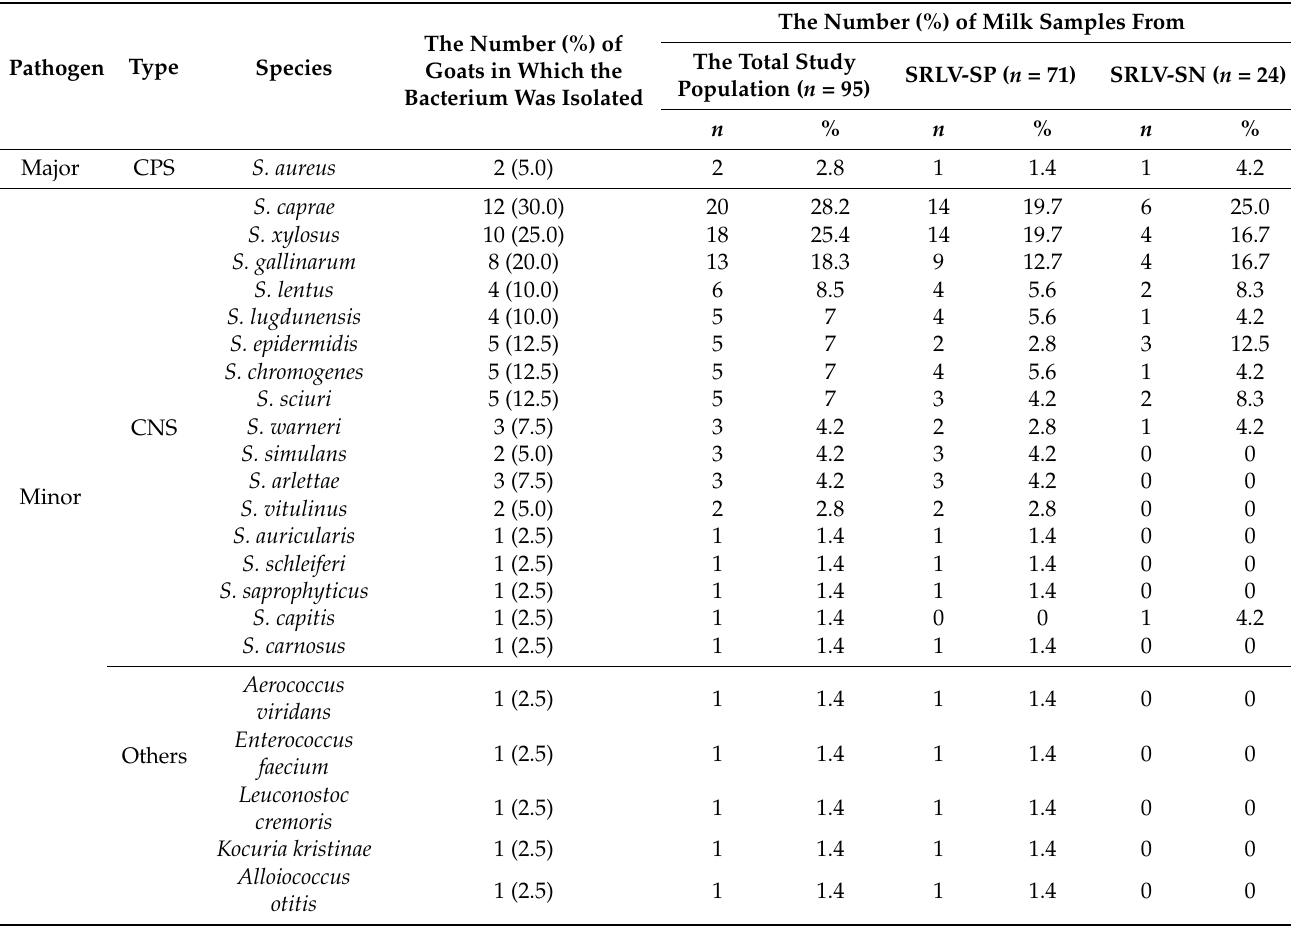
Table 2. Species of bacteria causing mastitis in 40 goats and their prevalence in milk samples from small ruminant lentivirus-seropositive (SRLV-SP) and seronegative (SRLV-SN) goats.